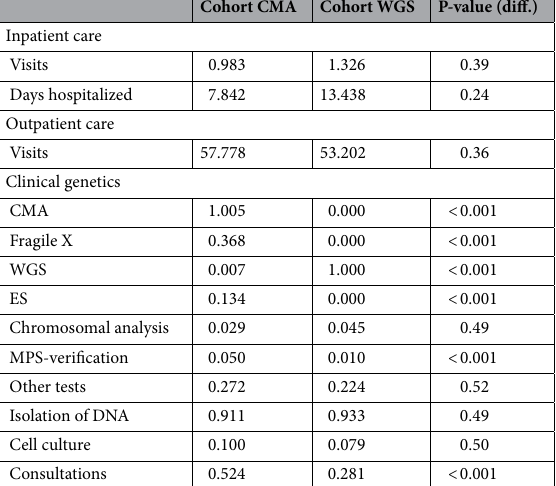
Cohort CMA Cohort WGS P-value